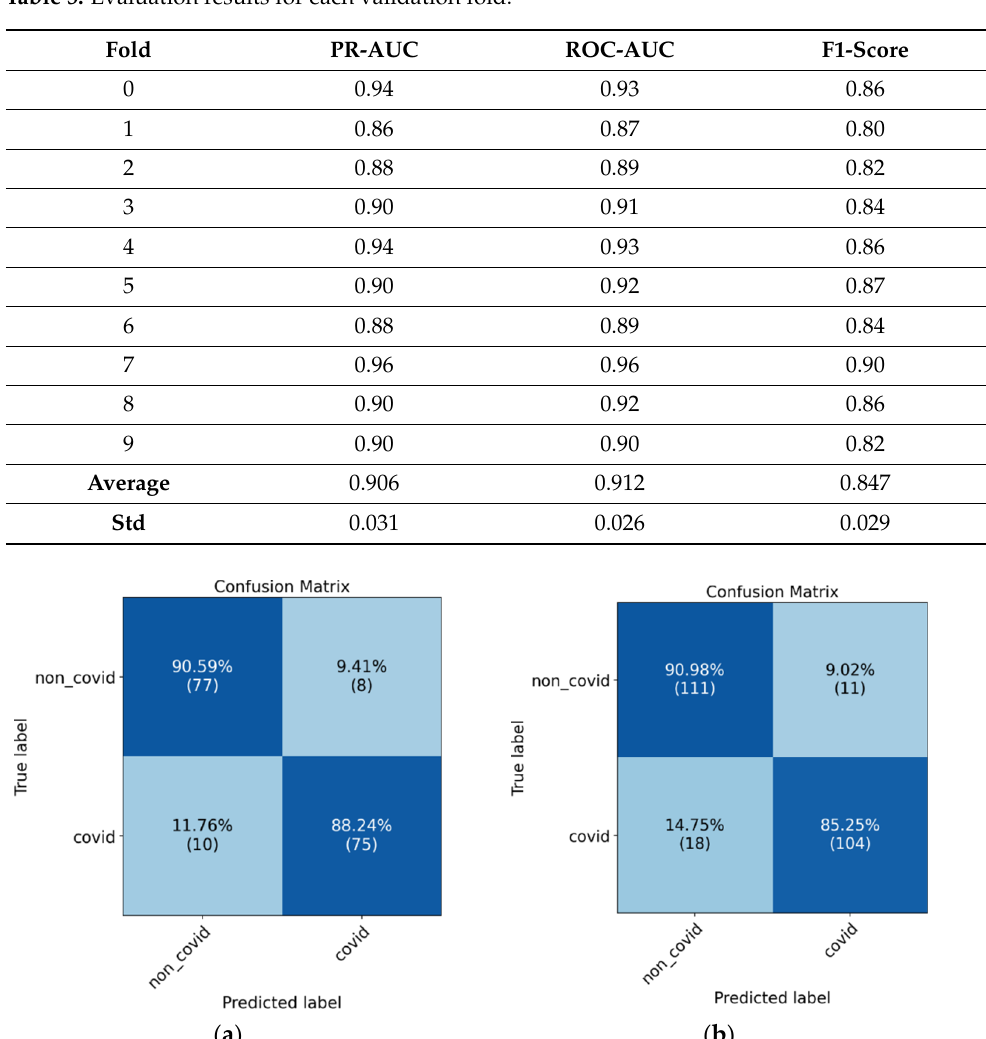
Table 5. Evaluation results for each validation fold.